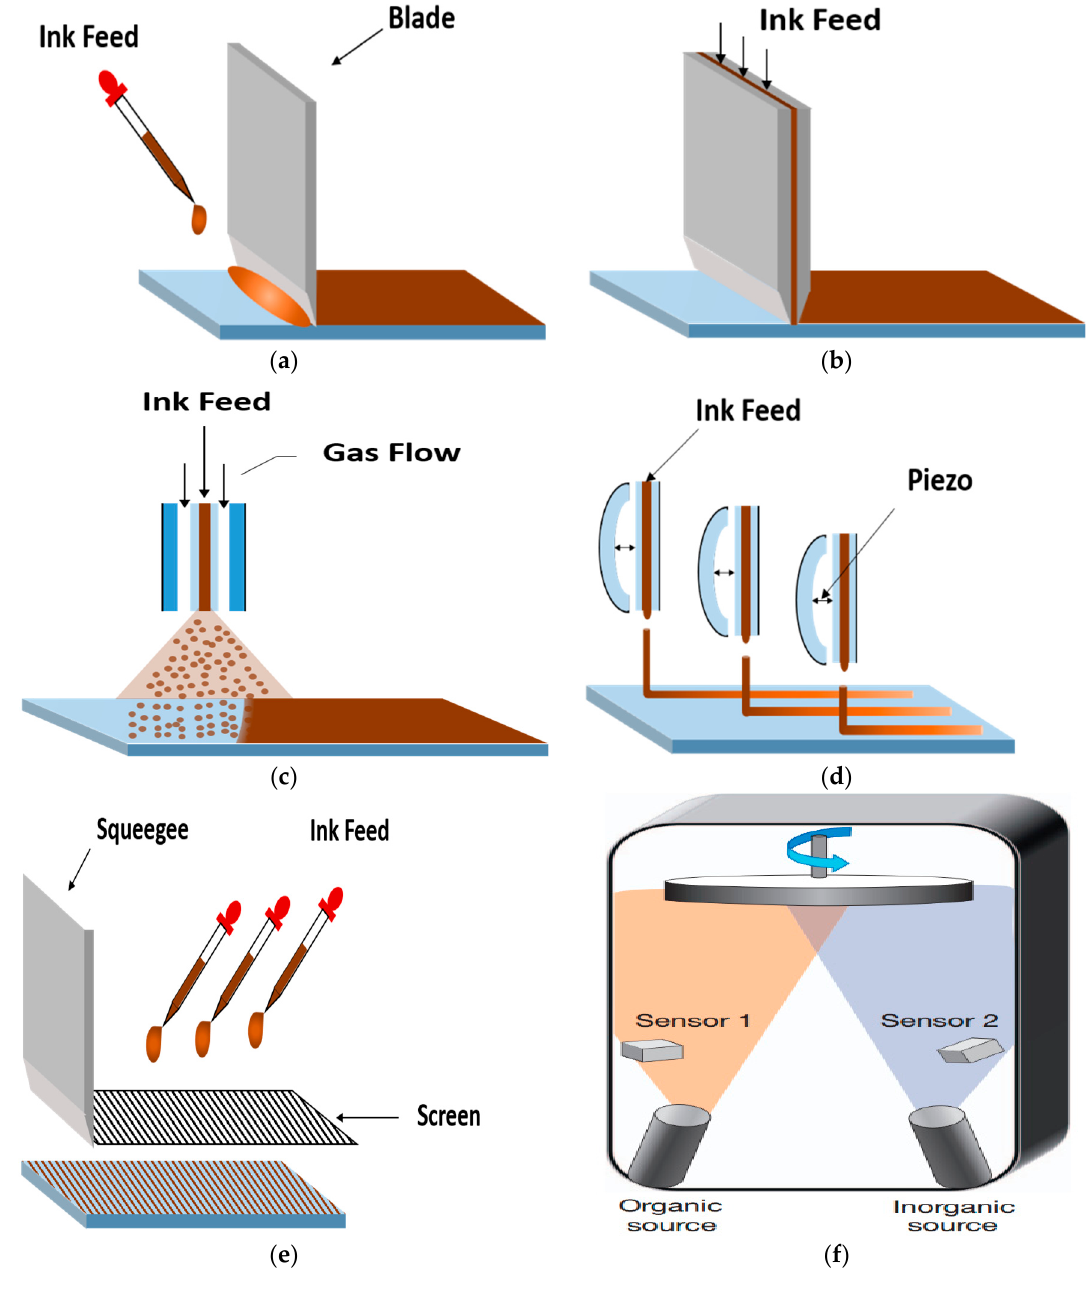
Figure 13. Scalable deposition methods: ( a ) Doctor-blade coating; ( b ) Slot-die coating; ( c ) Spray coating; ( d ) Inkjet printing; ( e ) Screen printing; ( f ) Vapor-phase deposition [183].